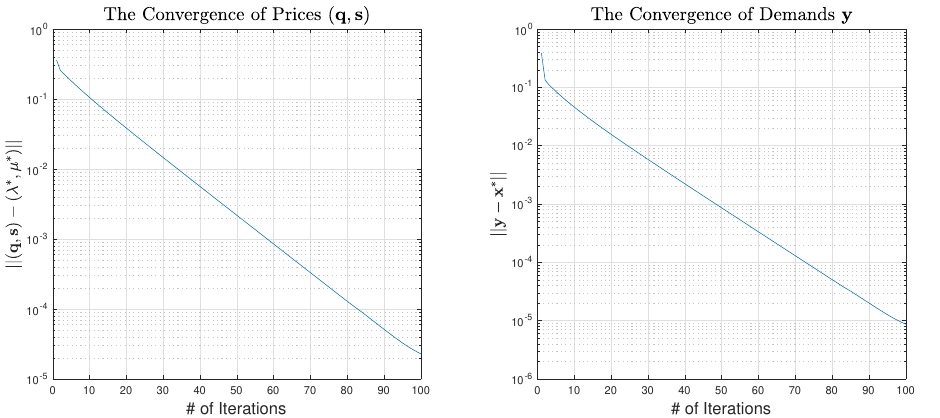
Figure 3. The convergence of the learning